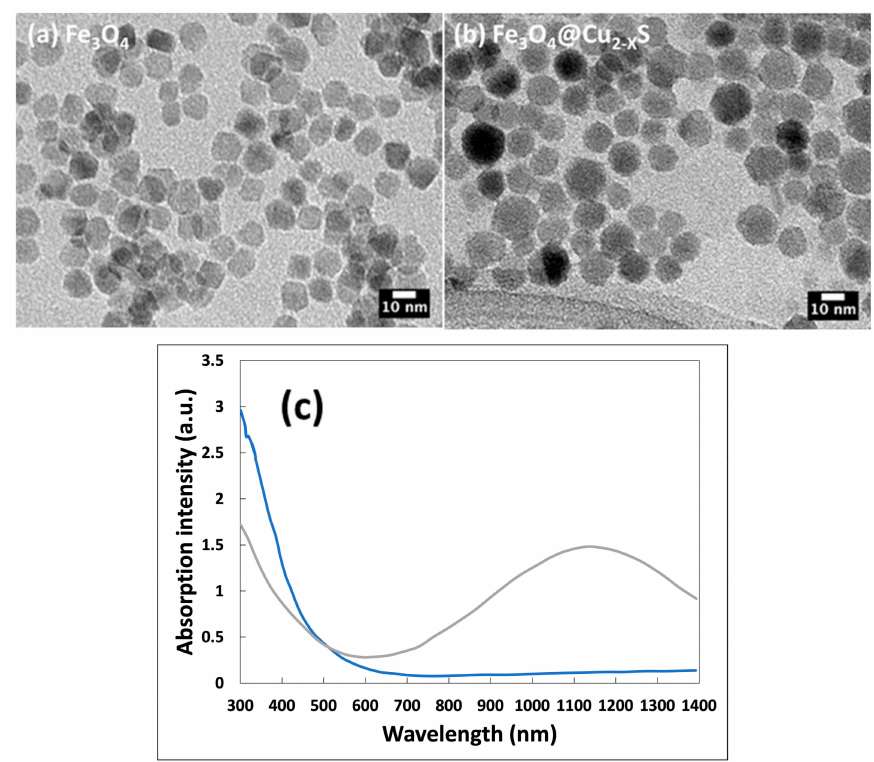
Figure 4. TEM micrographs of ( a ) Fe 3 O 4 and ( b ) Fe 3 O 4 @Cu 2 − x S nanoparticles, and ( c ) absorptions of the Fe 3 O 4 (blue line) and Fe 3 O 4 @Cu 2 − x S (grey line) nanoparticles